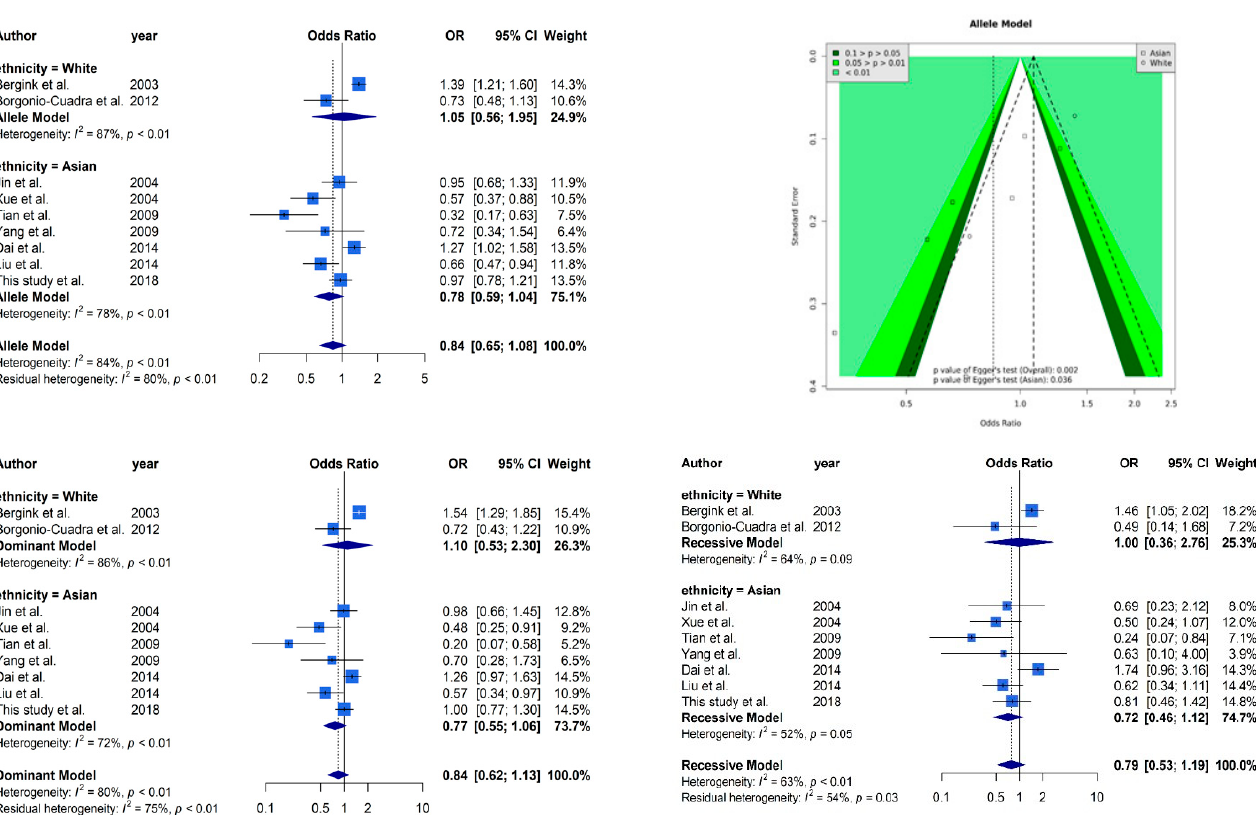
Figure 2. Selected results from the meta-analysis of ESR1 Xbal and knee OA. The top left subplot is a forest plot based on an allele model assumption (reference: A allele) and the top right subplot is a funnel plot based on the allele model assumption. The results obtained with the dominant (AG + GG vs. AA) and recessive (GG vs. AA + AG) models are presented at the bottom. All results are nonsignificant.